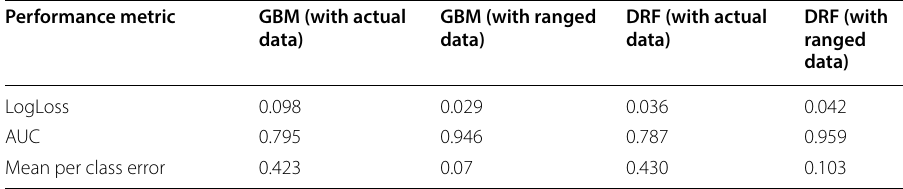
Table 4 Models’ performances during the testing phase Performance